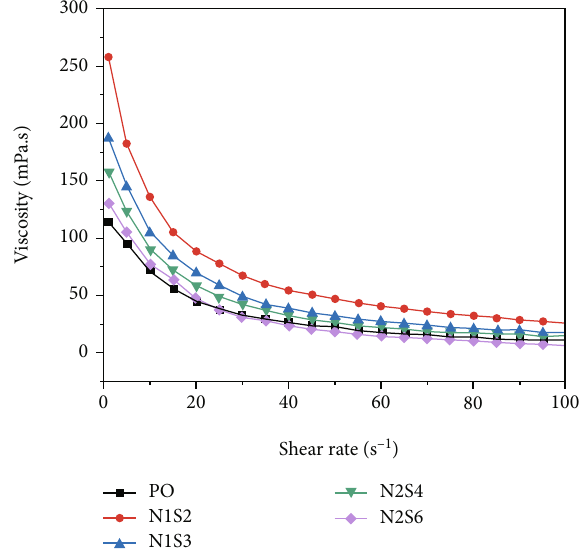
Figure 6: Viscosity of PO and biolubricants.